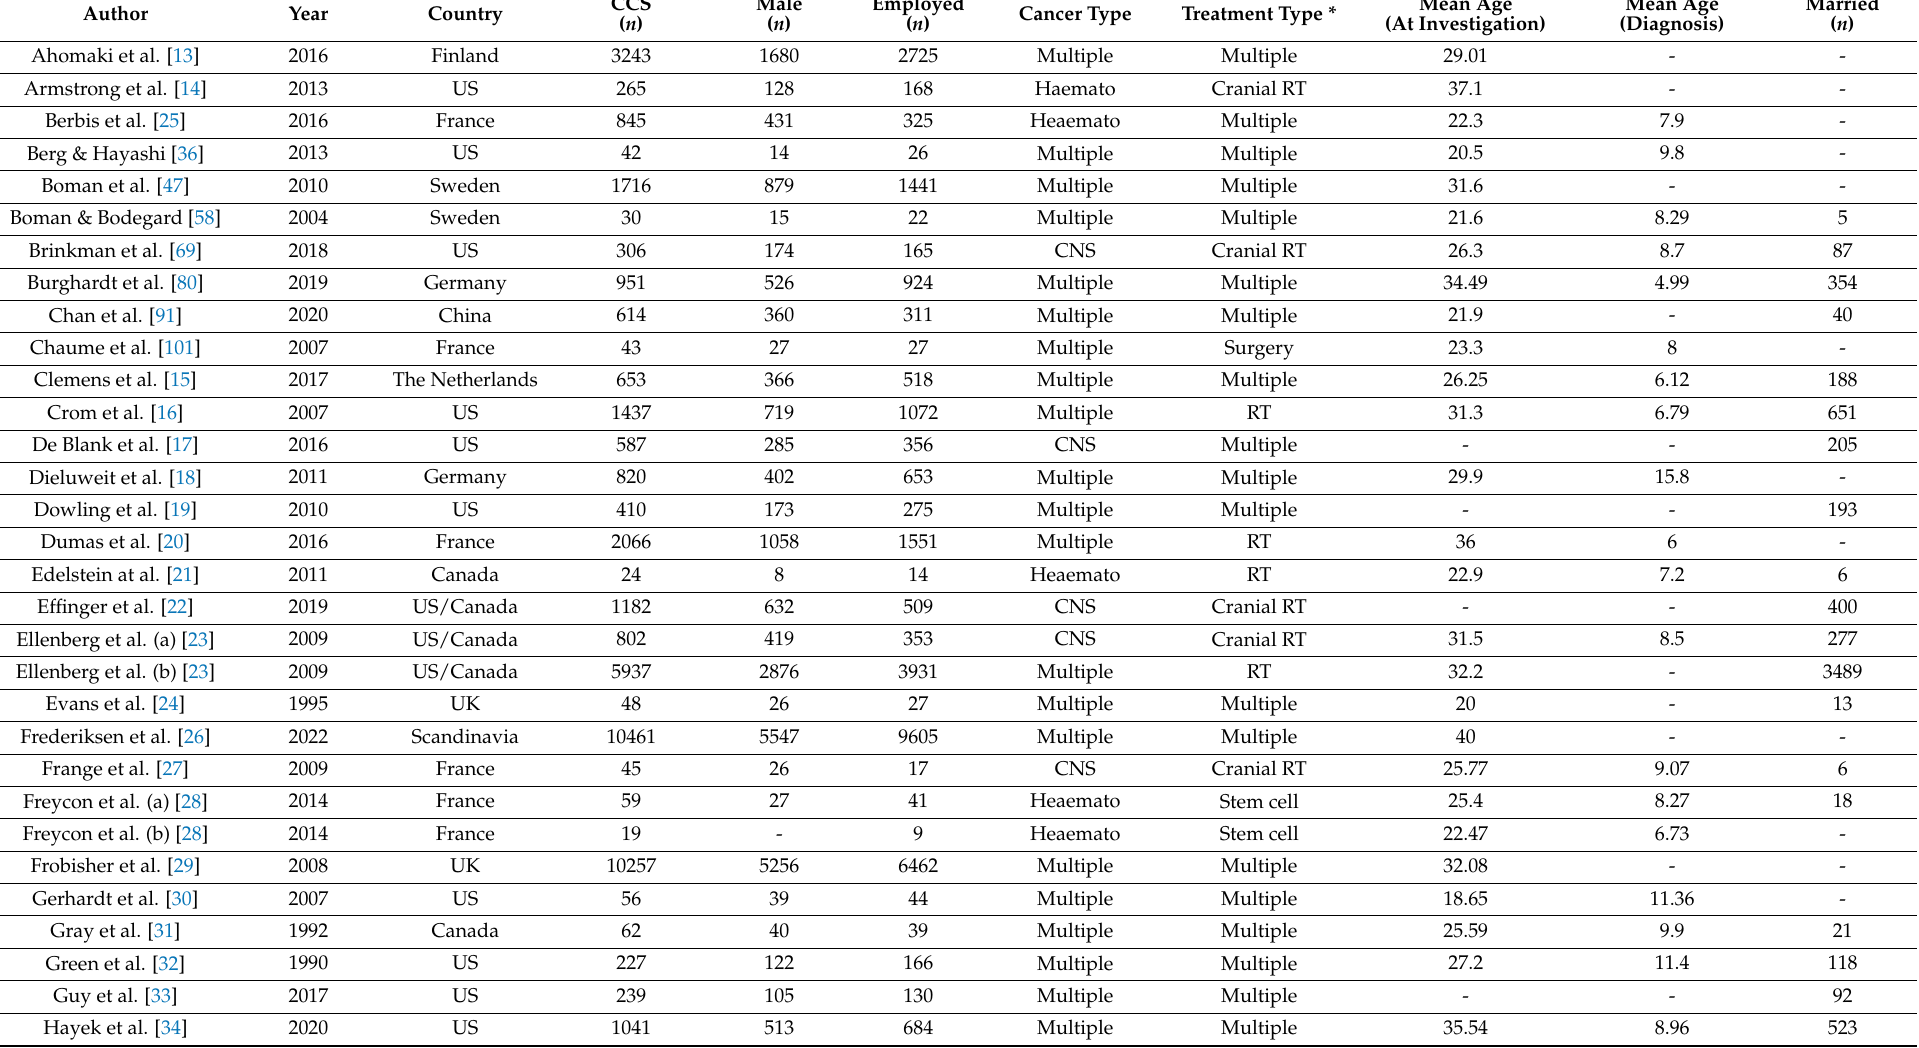
Table 1. Characteristics of included